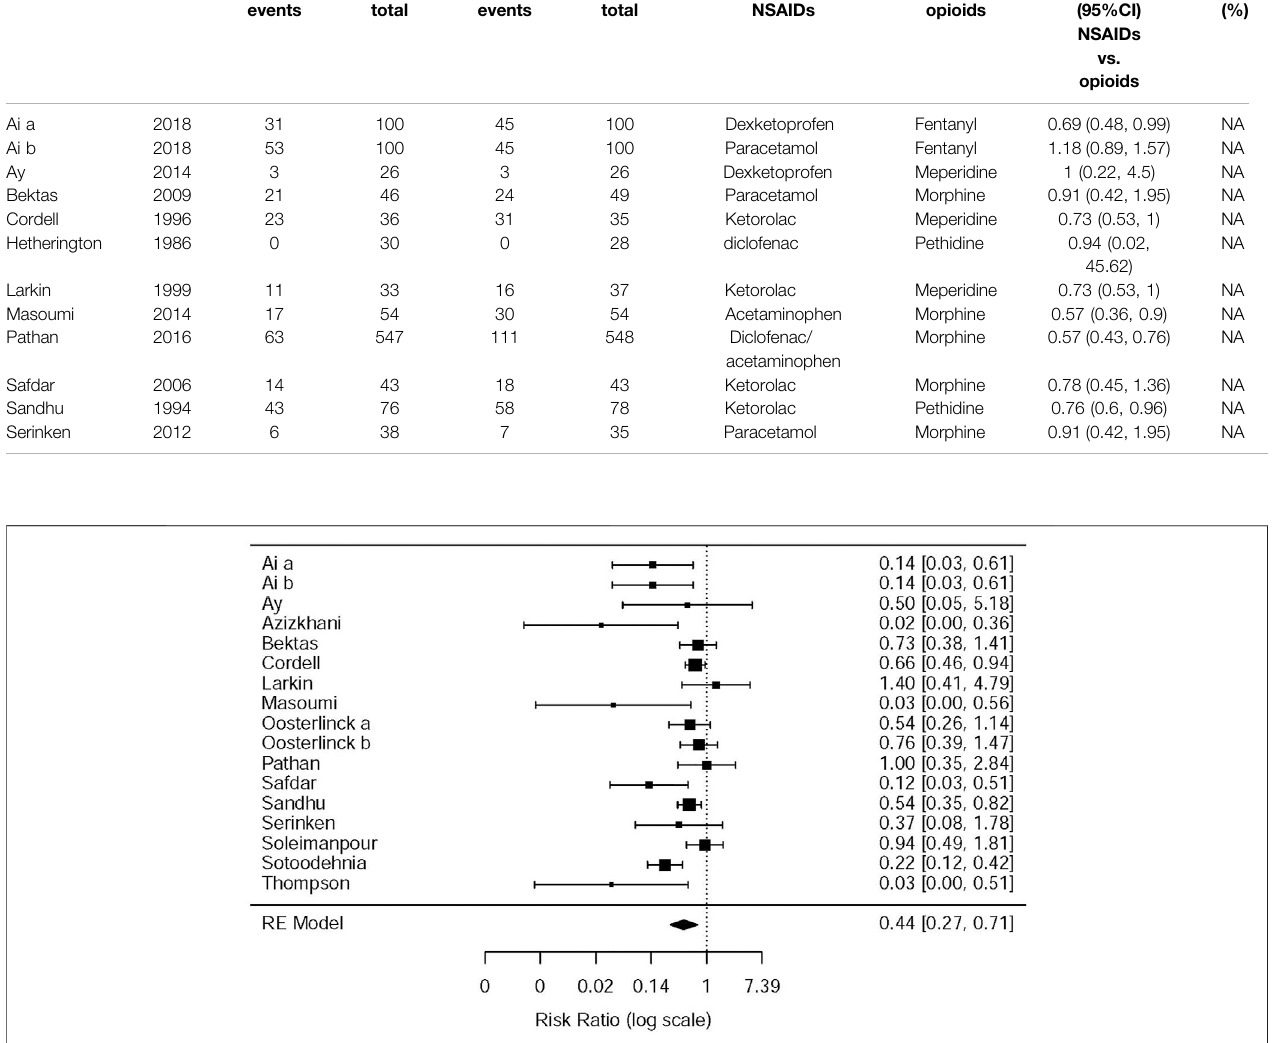
Frontiers in Pharmacology |